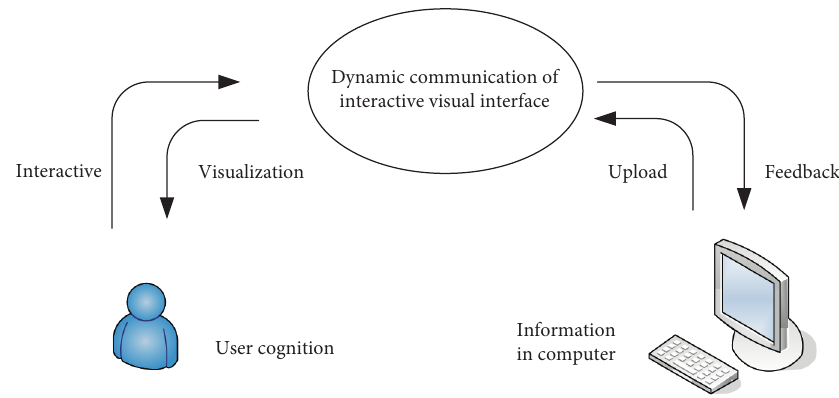
Figure 5: Process of human information